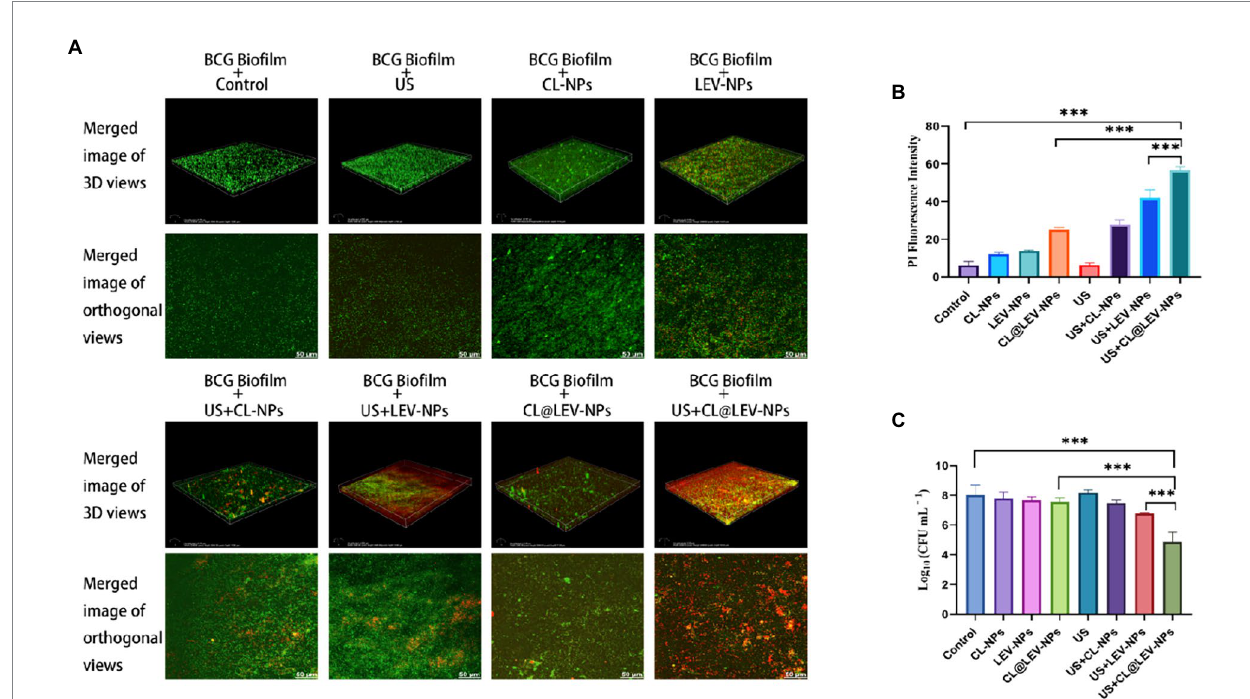
FIGURE 7 Antibacterial activity of BCG biofilm in vitro . (A) SYTO 9/PI Staining to observe the 3D reconstruction map and maximum area projection (200×) of BCG biofilm treated by different experimental groups; (B) Quantitative analysis of BCG biofilm after different treatments red fluorescence intensity; (C) Bacterial plate counts for each group at the end of the different experiments *** p <